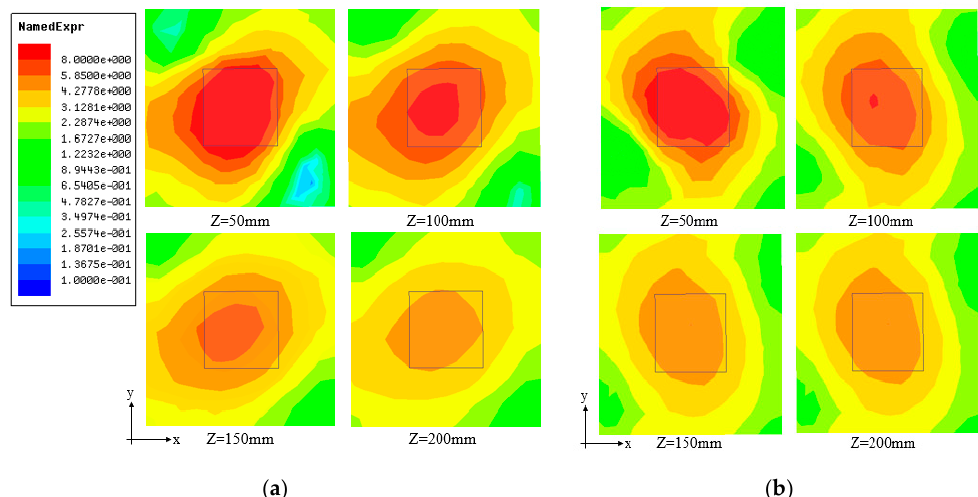
Figure 12. Distribution of simulated electric field components (Ex, Ey) at different heights with five spiral loops: ( a ) Ex distribution and ( b ) Ey distribution.